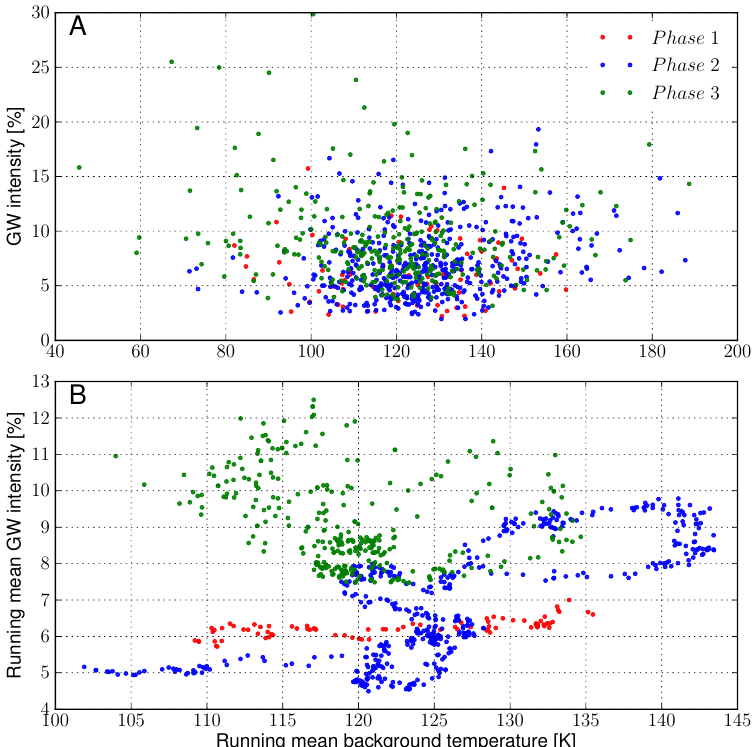
Figure 12. Relative density amplitude as a function of the background temperature: ( A ) scatter plot for the individual passes, and ( B ) the running mean of the GW intensity vs. the running mean of the background temperature. The running averages have been calculated with respect to the latitude in the manner similar to that in Figures 6 and